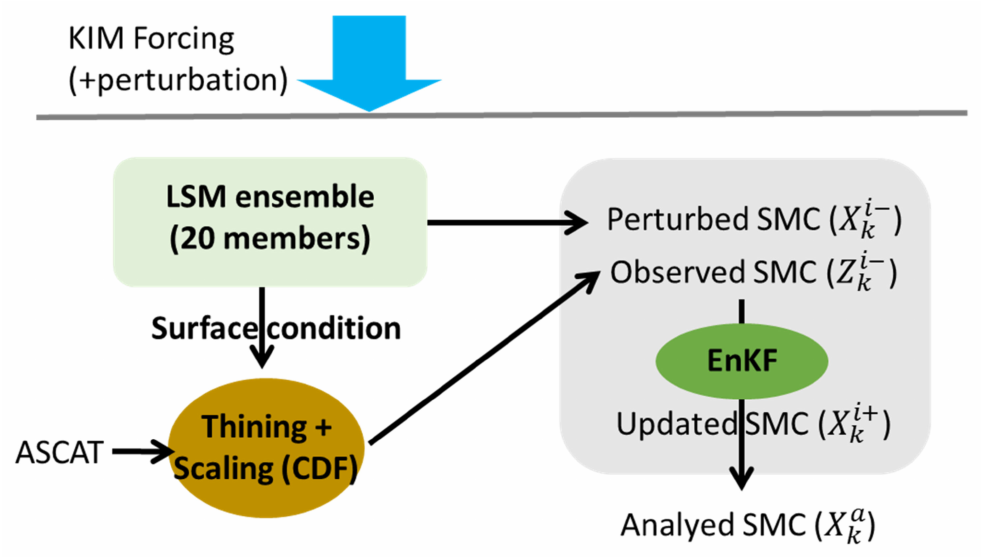
Figure 3. Soil moisture data assimilation